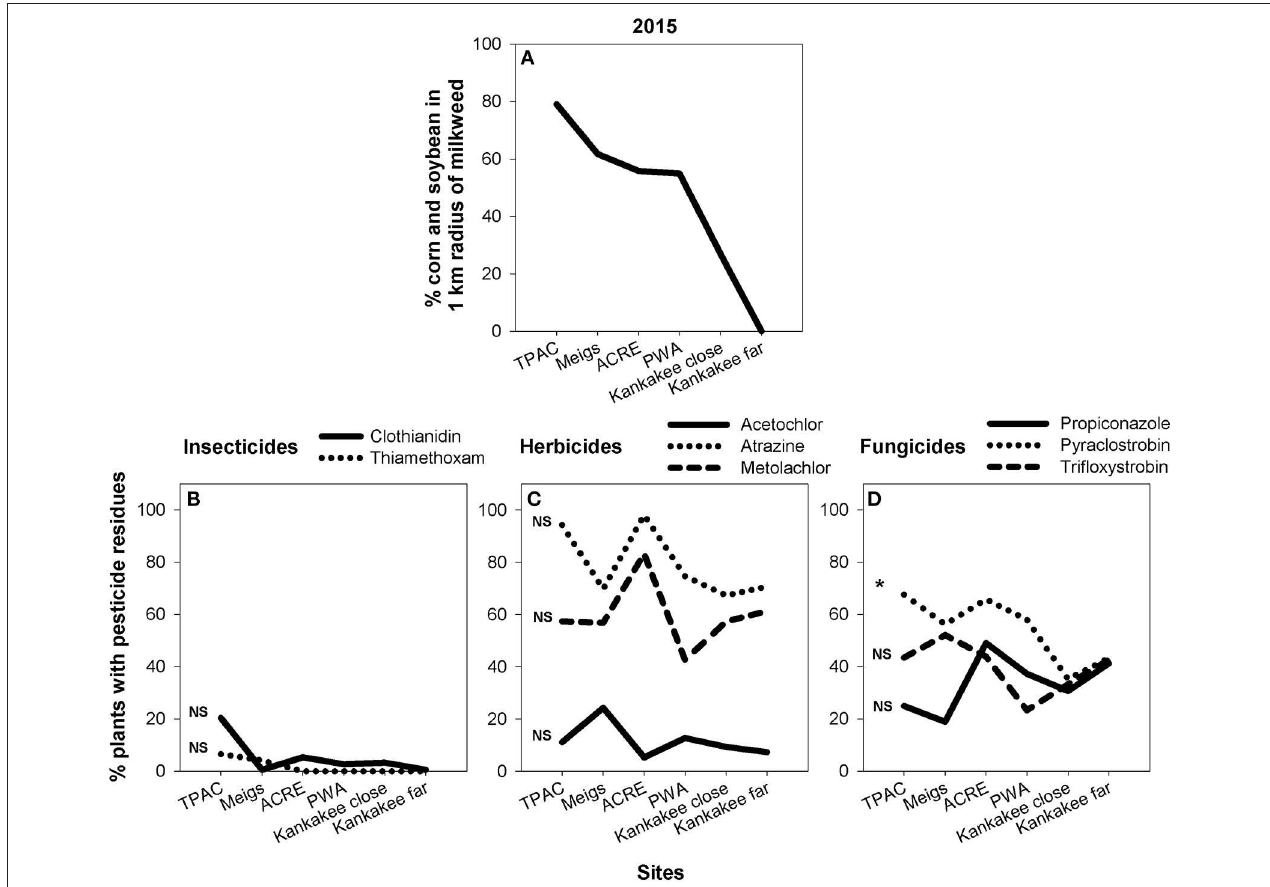
FIGURE 6 | Area of corn and soybean, expressed as percent of total land use, in 1km buffer surrounding the six milkweed sites sampled in 2015 (A) and corresponding site-level changes in insecticide (B) , herbicide (C) , and fungicide (D) residues associated with milkweed leaves. Statistical analyses compare, within each pesticide, the relationship between agricultural intensification and pesticide detection frequency. * p < 0.05, ns = not